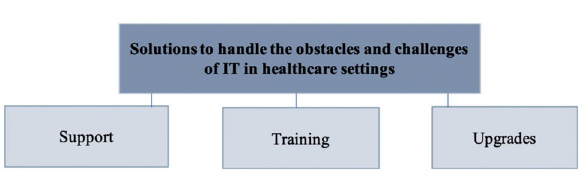
Fig. 4 Solution to handle the challenges of IT in healthcare settings